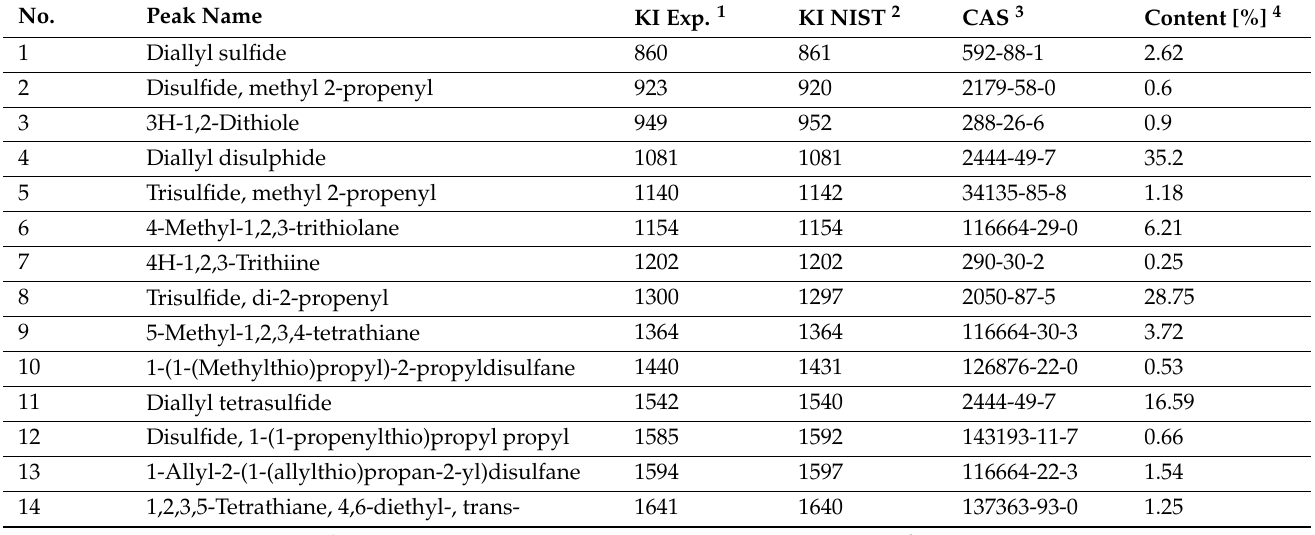
Table 11. GC-MS profile of garlic essential oil.